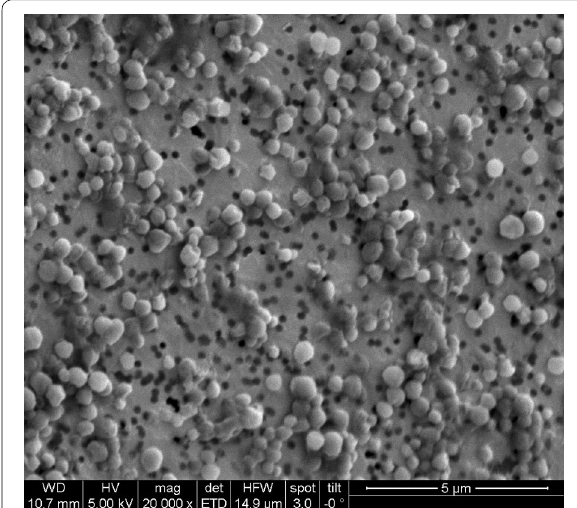
Fig. 6 Scanning electron microscopy image of PHB granules from Synechocystis sp. PCC 6714 cells cultivated photoautotrophically and N and P